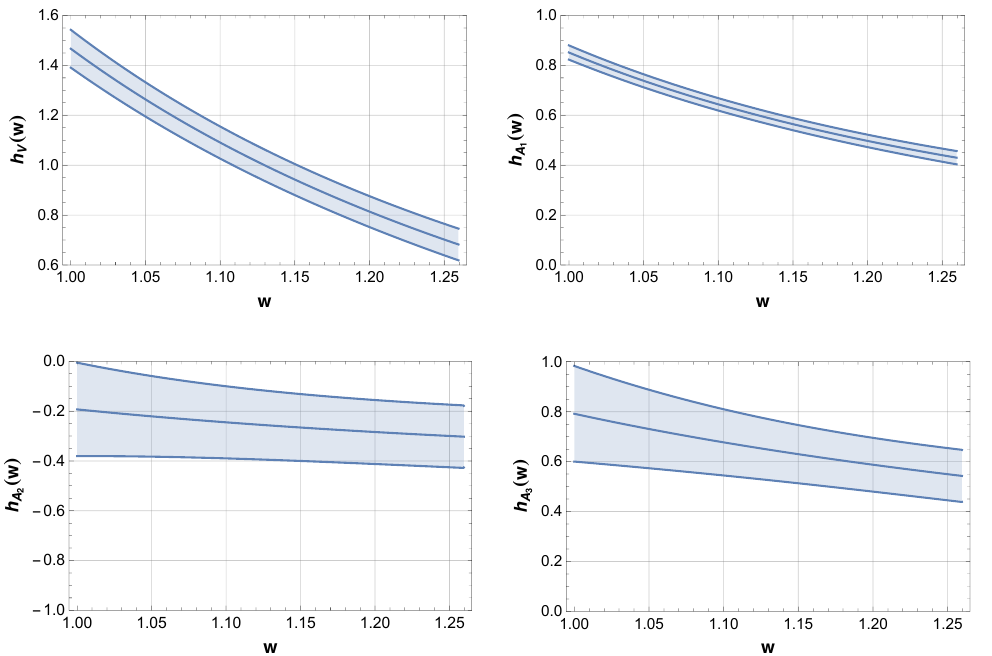
and h obtained using the lattice QCD results , h A A 3 1 2